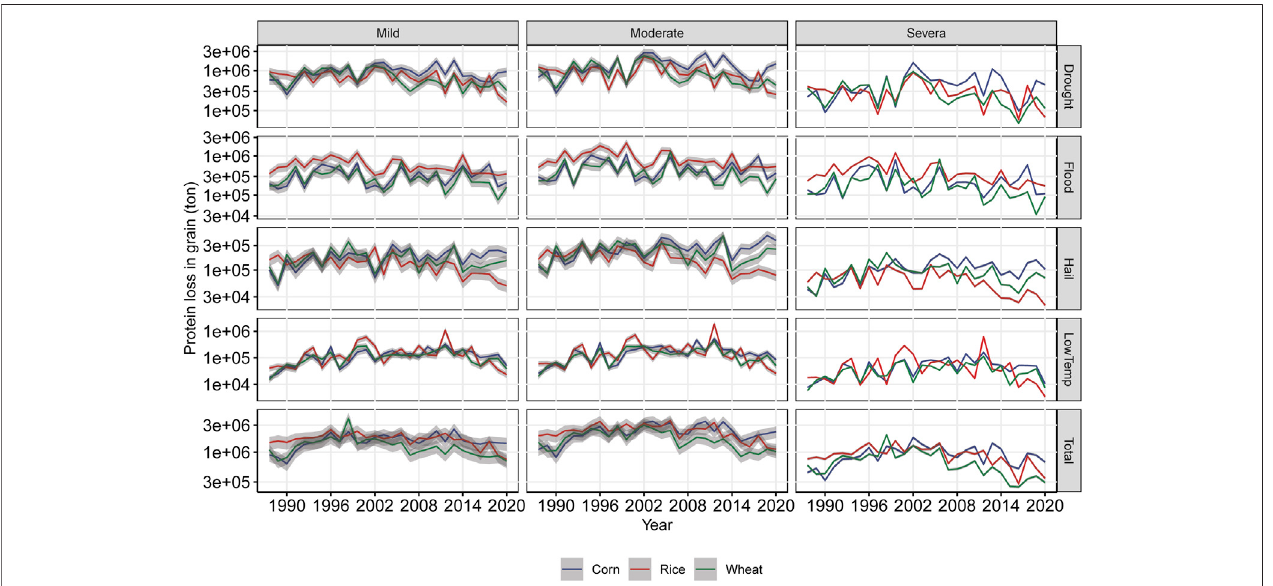
FIGURE 8 | Trends in protein loss from the grain harvest in maize, rice, and wheat due to different natural disasters from 1988 to 2020. The shaded regions represent one standard deviation of the protein loss in the grain.